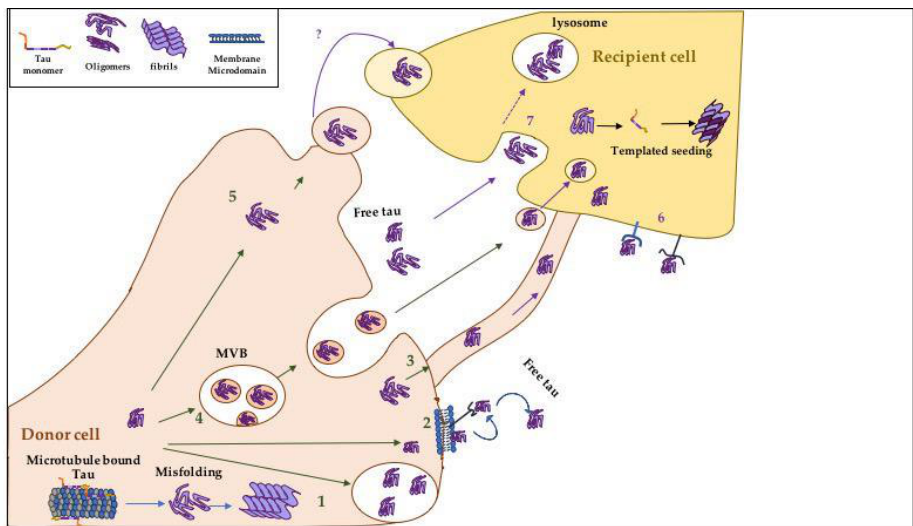
Figure 3. Various hypothesized mechanisms involved in the prion-like spreading of tau pathology between adjacent or nearby cells (inspired by figures in [282,283]). The mechanisms include the spread of tauopathy seeds between adjacent cells. (A) Tau aggregates inside neurons can spread from the donor (pre-synaptic) to recipient neurons (post-synaptic) via various mechanisms. Donor cell: (1) Regulated release via either soluble N -ethylmaleimide-sensitive factor attachment protein receptor (SNARE)-dependent exocytosis, endo-lysosomal pathways mediated by Rab7, or EB proteins; (2) direct secretion via plasma-membrane (PM) translocation that includes the clustering of tau at the PM, interactions with specific lipids and release from the PM guided by HSPG cell-surface receptors; (3) intercellular transfer between neurons via tunneling nanotubes; (4) the fusion of multivesicular bodies (MVB) to plasma membranes and secretion of tau aggregates in exosomes; (5) the release of tau aggregates in ectosomes. At the recipient cell(s), released tau aggregates can be taken up by various mechanisms, including (6) receptor-mediated endocytosis (HSPGs and APP), (7) macropinocytosis, or dynamin-dependent endocytosis. The process by which cells take up exosomes and ectosomes is still unclear.